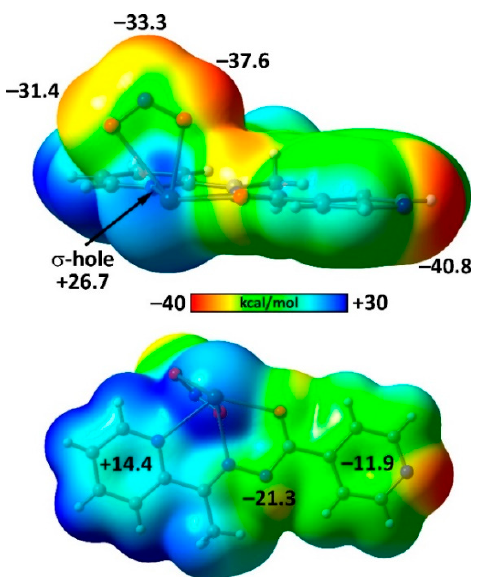
Figure 5. Two views of the molecular electrostatic potential (MEP) surface of [PbL(NO 2 )] (isosurface 0.001 a.u.). The blue color is used for positive MEP values, and the red color for negative values, as indicated in the legend.